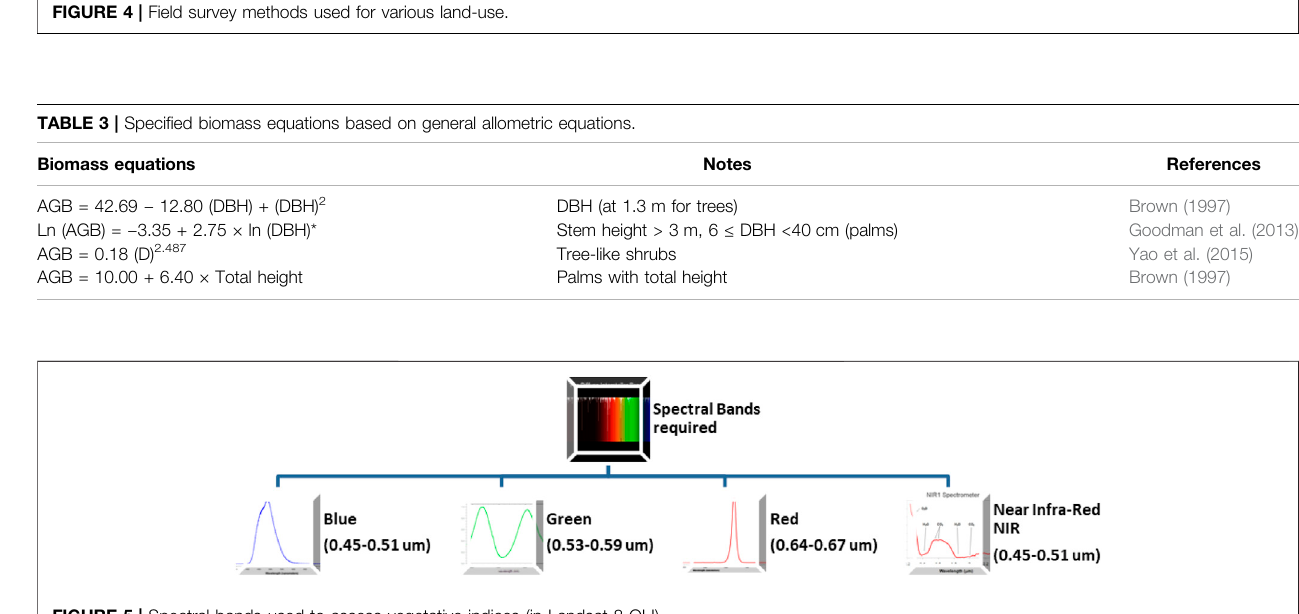
FIGURE 5 | Spectral bands used to assess vegetative indices (in Landsat 8 OLI).